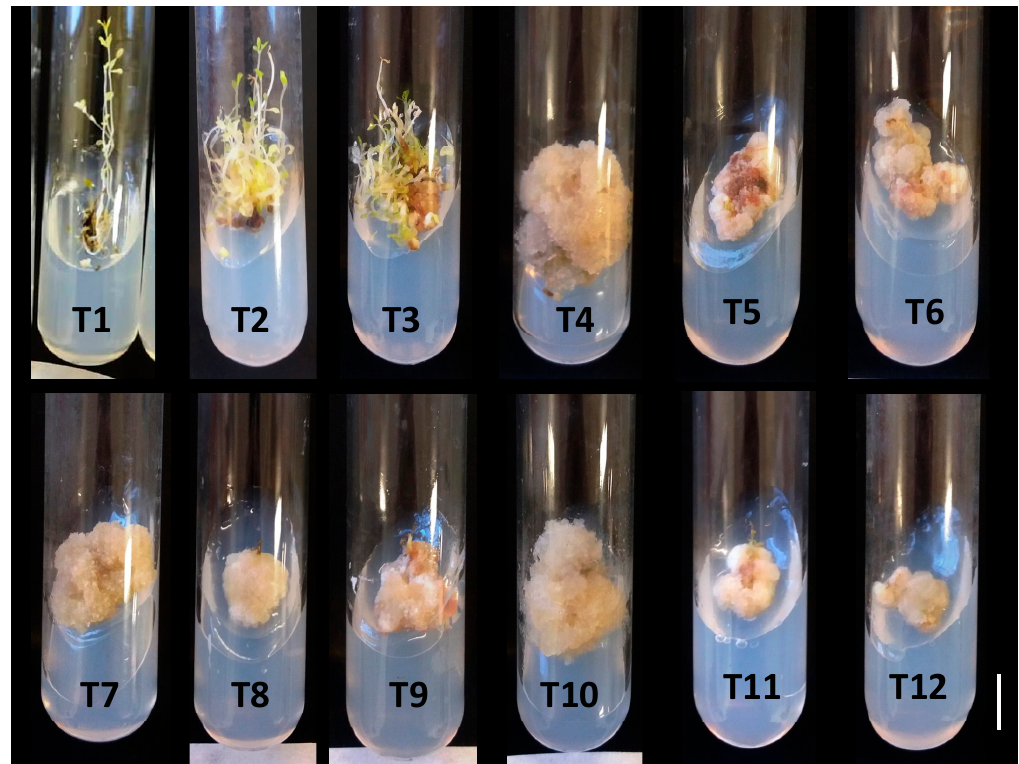
Figure 1. Differential responses of nodal segments of Phyllanthus amarus obtained with individual or mixed treatments with 2,4-dichlorophenoxyacetic acid (2,4-D) and 6-benzyladenine (BA) (mg / L): T1, free of phytoregulators (control); T2, BA 1.0; T3, BA 2.0; 0.25 mg / L 2,4-D (T4) + BA 1.0 (T5) or 2.0 (T6); 0.50 mg / L 2,4-D (T7) + BA 1.0 (T8) or 2.0 (T9); 0.75 mg / L 2,4-D (T10) + BA 1.0 (T11) or 2.0 (T12). White bar = 1.0 cm.